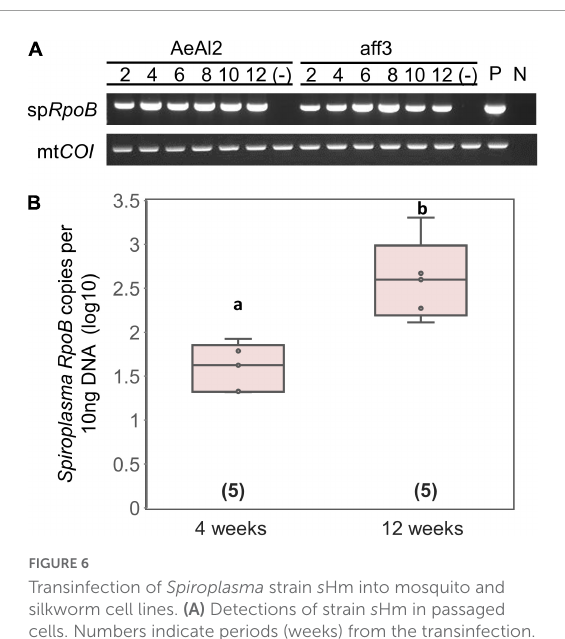
FIGURE6 Transinfection of Spiroplasma strain s Hm into mosquito and silkworm cell lines. (A) Detections of strain s Hm in passaged cells. Numbers indicate periods (weeks) from the transinfection. P (positive control): S + female; N (negative control): NSR female. (B) Spiroplasma density in AeAl2 cells deduced from RpoB copy numbers per 10 ng DNA. Different letters indicate significant differences between groups (Steel–Dwass test, P <